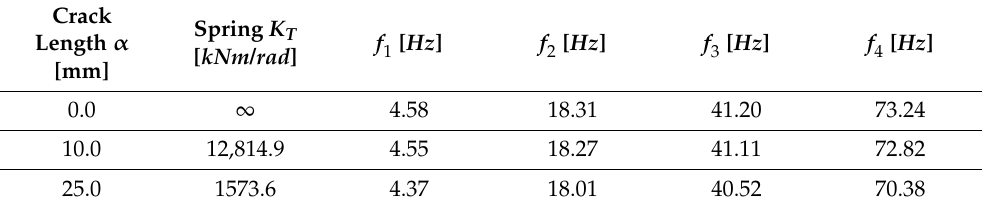
Table 2. First four eigenfrequencies f i of the simply supported beam with and without a crack.